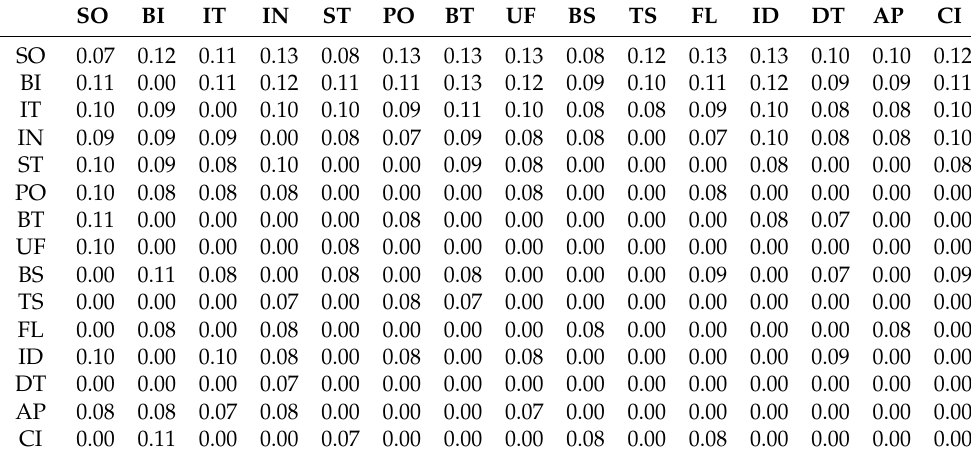
Step 6: The crisp total-relation matrix was generated by defuzzifing the fuzzy total-relation matrix into crisp values, using the CSFS method (Equations (8)–(14)), as shown in Table 11. Table 11. Crisp total-relation matrix.